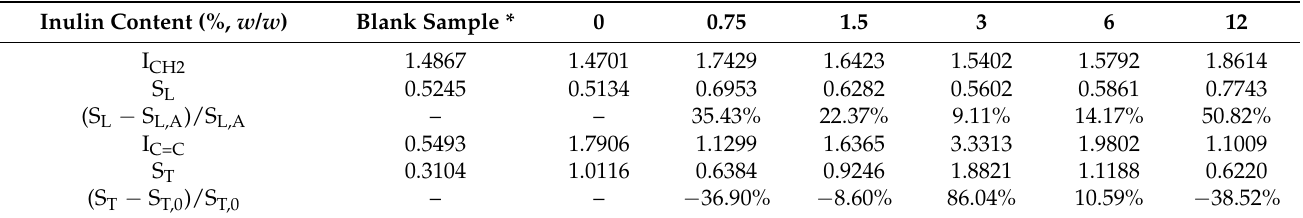
Figure 5. Particle size distribution of liposomes under different storage conditions: ( A ) 4 °C, 2 d ( B ) 37°C, 6 h ( C ) 65°C, 30 min and ( D ) 90°C, 1 min. (E) Changes in the RR of different temperatures of storage. The results are represented as the mean ± sd (n = 3). RR: retention rate. Table 1. The order parameters and their change rates for the lateral interaction between chains of cinnamaldehyde liposomes with different inulin